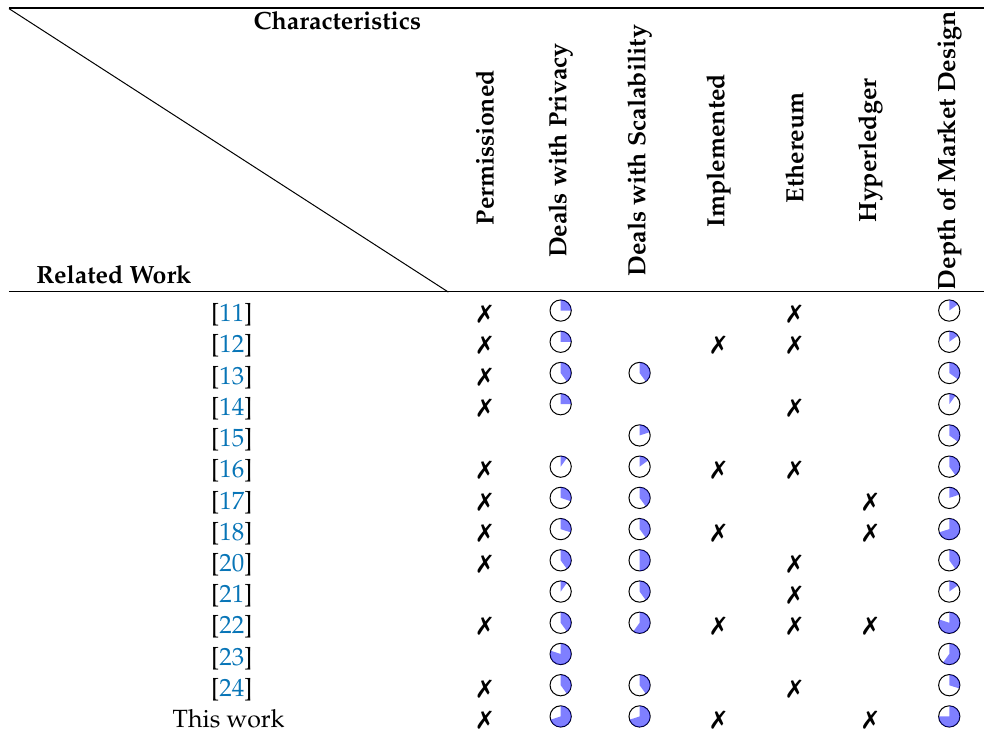
Table 1. Related work